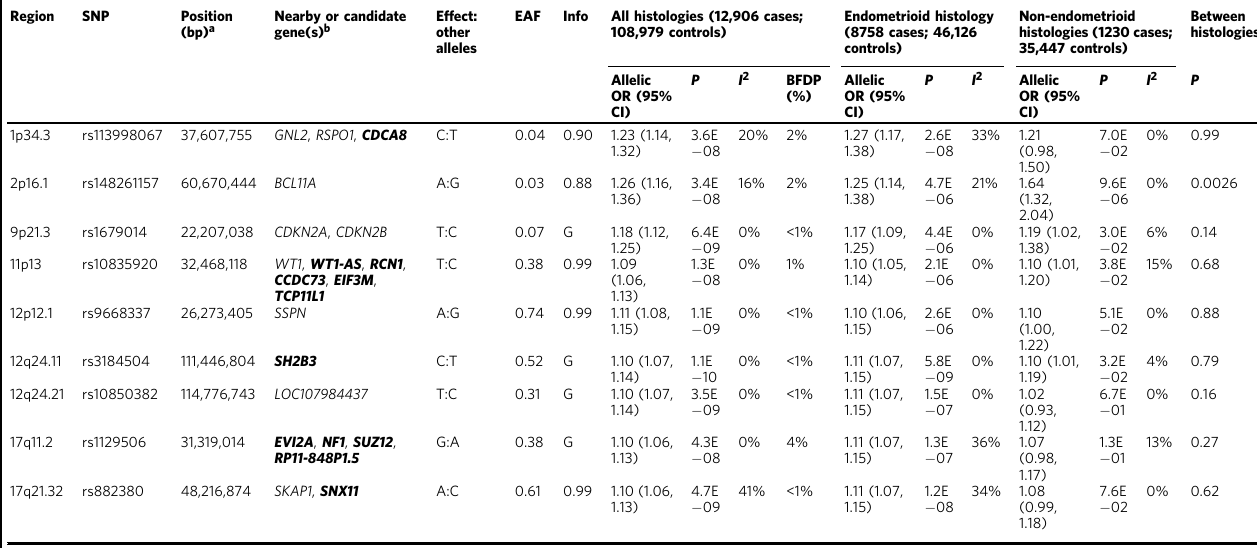
Table 2 Meta-analysis results for newly identi fi ed genome-wide signi fi cant endometrial cancer risk loci Region SNP Position